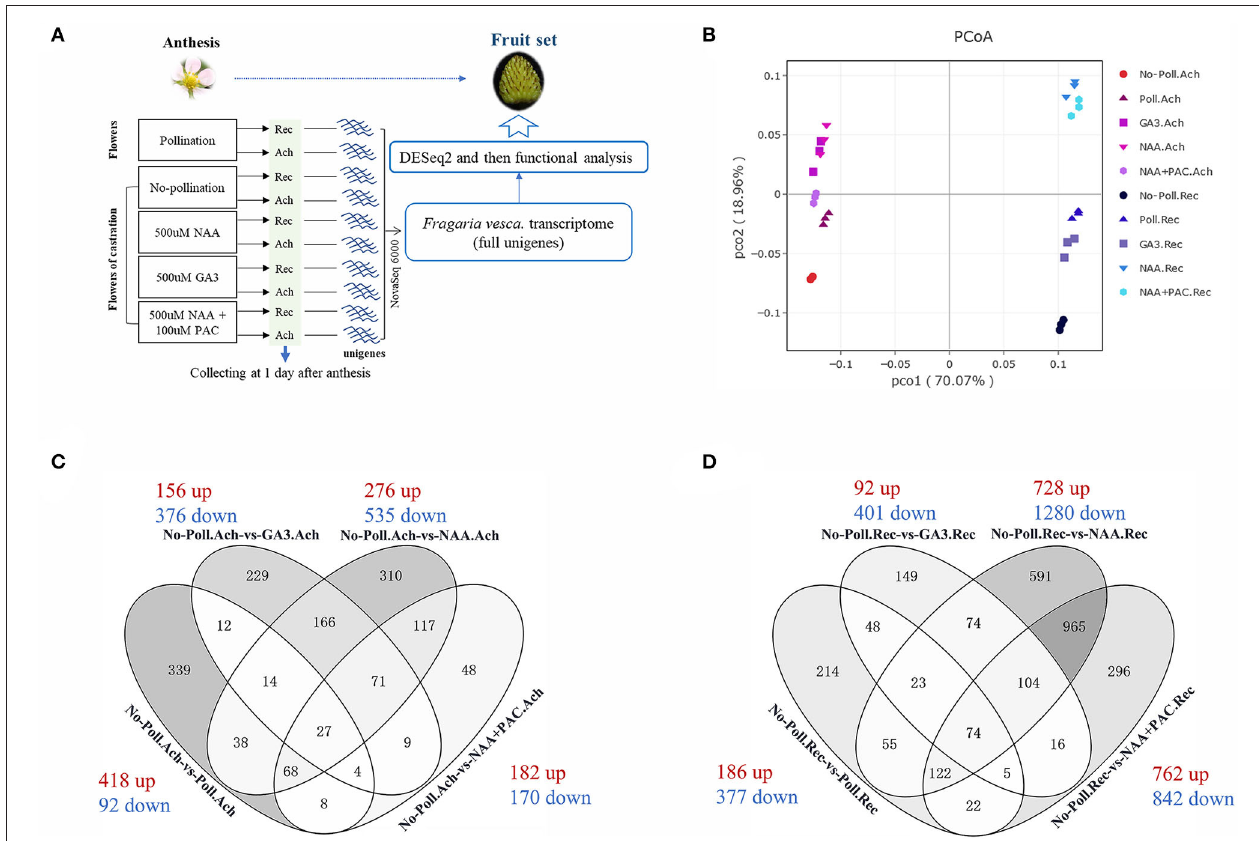
FIGURE 3 | Global gene transcription in achenes and receptacles during fruit set initiation responding to auxin and pollination. (A) Experimental procedure for RNAseq analysis. Rec represents receptacle, and Ach represents achene. (B) PCoA based on gene expression. The whole transcription data were used, and X-ray and Y-ray show the distance between each sample. No-poll represents no-pollination. Poll represents pollination. (C,D) Overlapping set of the DEGs identified in the achenes (C) and receptacles (D) under different treatments. Numbers of the upregulated gene (red) and downregulated gene (blue) are shown for each corresponding groups. P < 0.05, |log2(fold change)| >